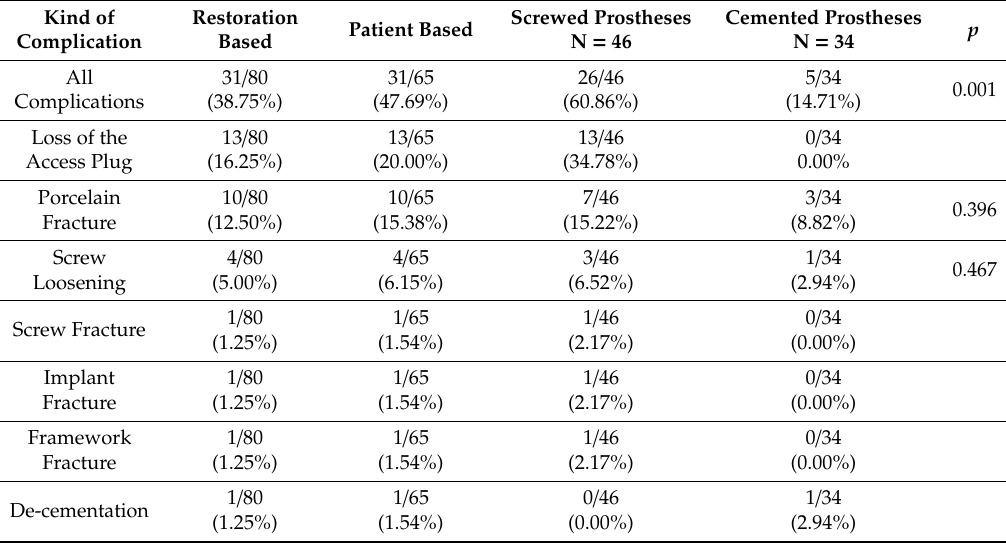
Table 12. Distribution of mechanical-technical